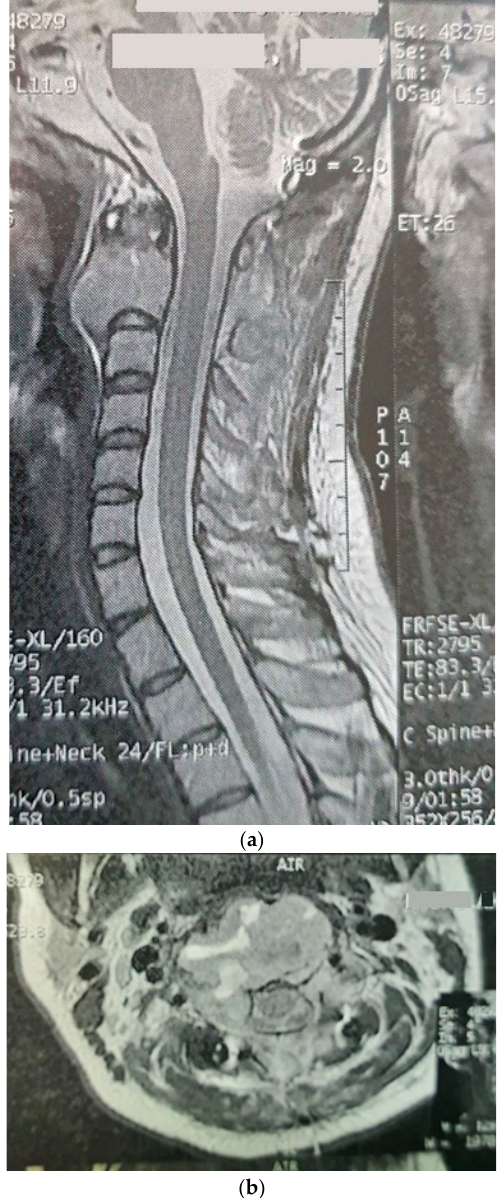
Figure 1. Sagitta ( a ) and axial ( b ) gadolinium-enhanced MRI showing the tumor in the C2 body. Because of vertebral instability, the patients underwent craniocervical fixation and tumor sampling through the C2 pedicle. The histopathologic examination reported an atypical histiocytic tumor infiltrated with hemophagocytosis. In the immunohistochemical examination, CD3, CD15, CD20, CD30, CD34, S100, GFAP, desmin, and EMA were negative and CD68, CD163, and vimentin were positive. ki67 was 15%. The positron